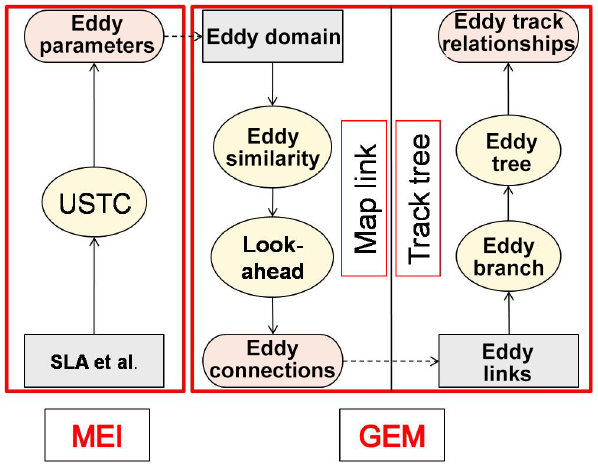
Figure 4. Flowchart of the systems. Mononuclear eddy identifica- tion (MEI) uses SLA to identify eddies via the Universal Splitting Technology for Circulations (USTC) method. The GEM, which has the two independent parts of “Map link” and “Track tree”, then uses the previously identified eddies for